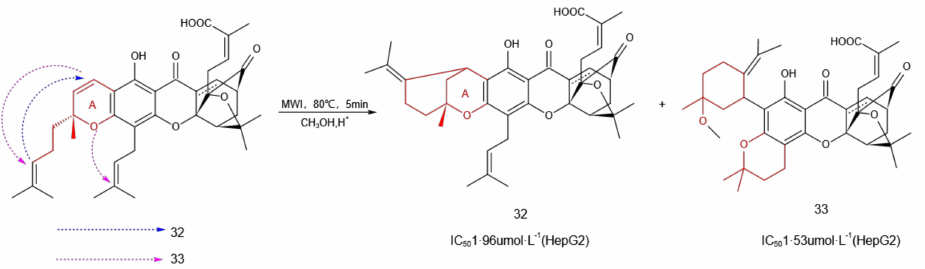
Figure 8. Structural modification of the A